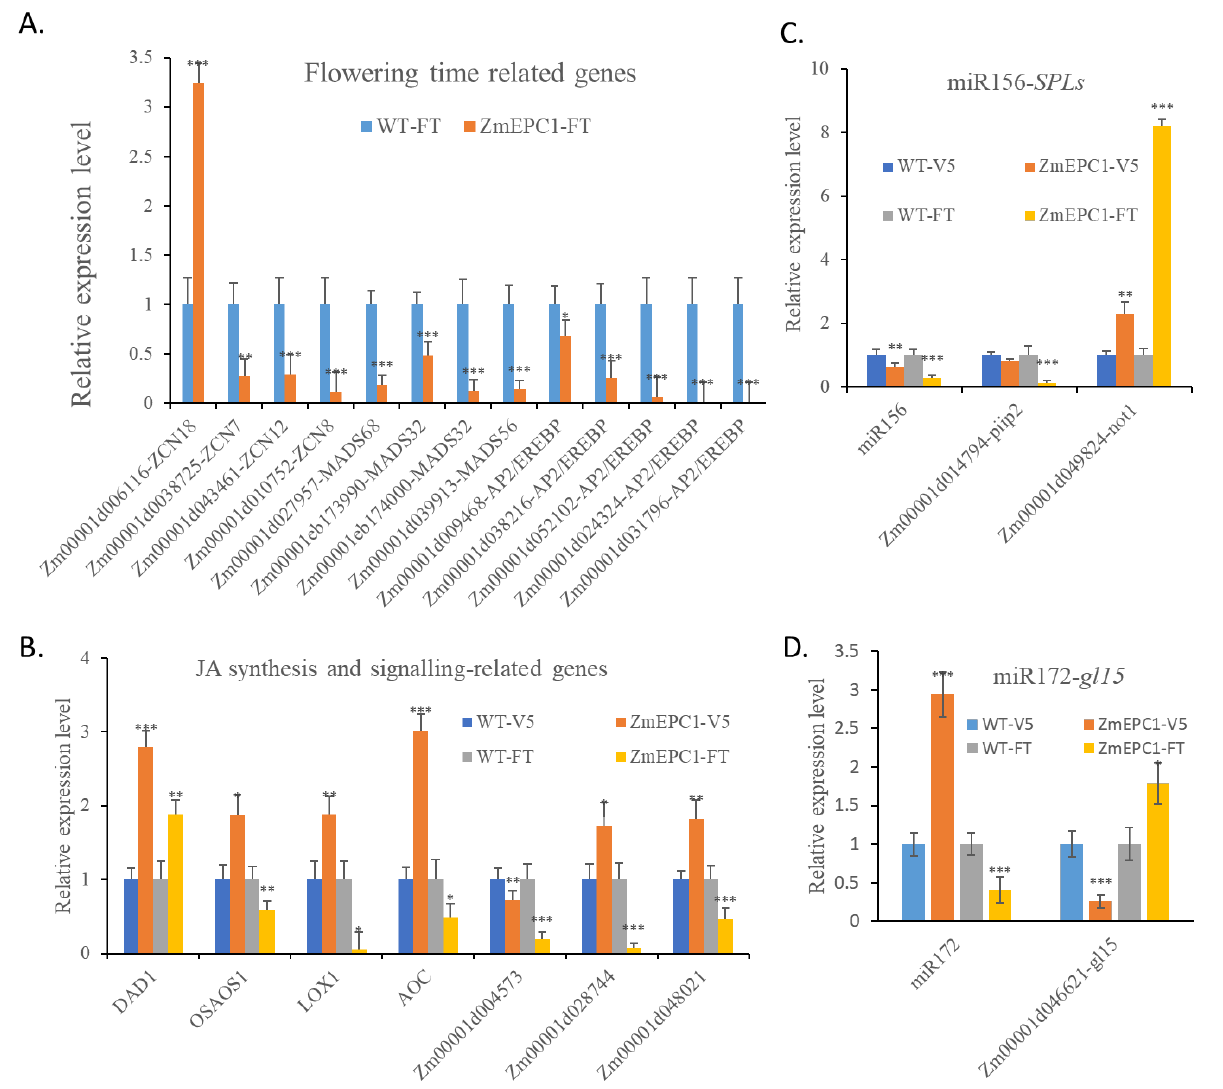
Figure 8. RT-qPCR for flowering stage, JA biosynthesis-related genes and miR156- SPLs in ZmEPC1 mutants. ( A ) RT-qPCR analysis for flowering time related genes; ( B ) RT-qPCR analysis for JA synthesis and signaling related genes; ( C ) RT-qPCR analysis for miR156 and its target genes; ( D ) RT-qPCR analysis for miR172 and its target gene gl15 . *, **, *** represent the difference significant level at p < 0.05, p < 0.01, p < 0.001, respectively.